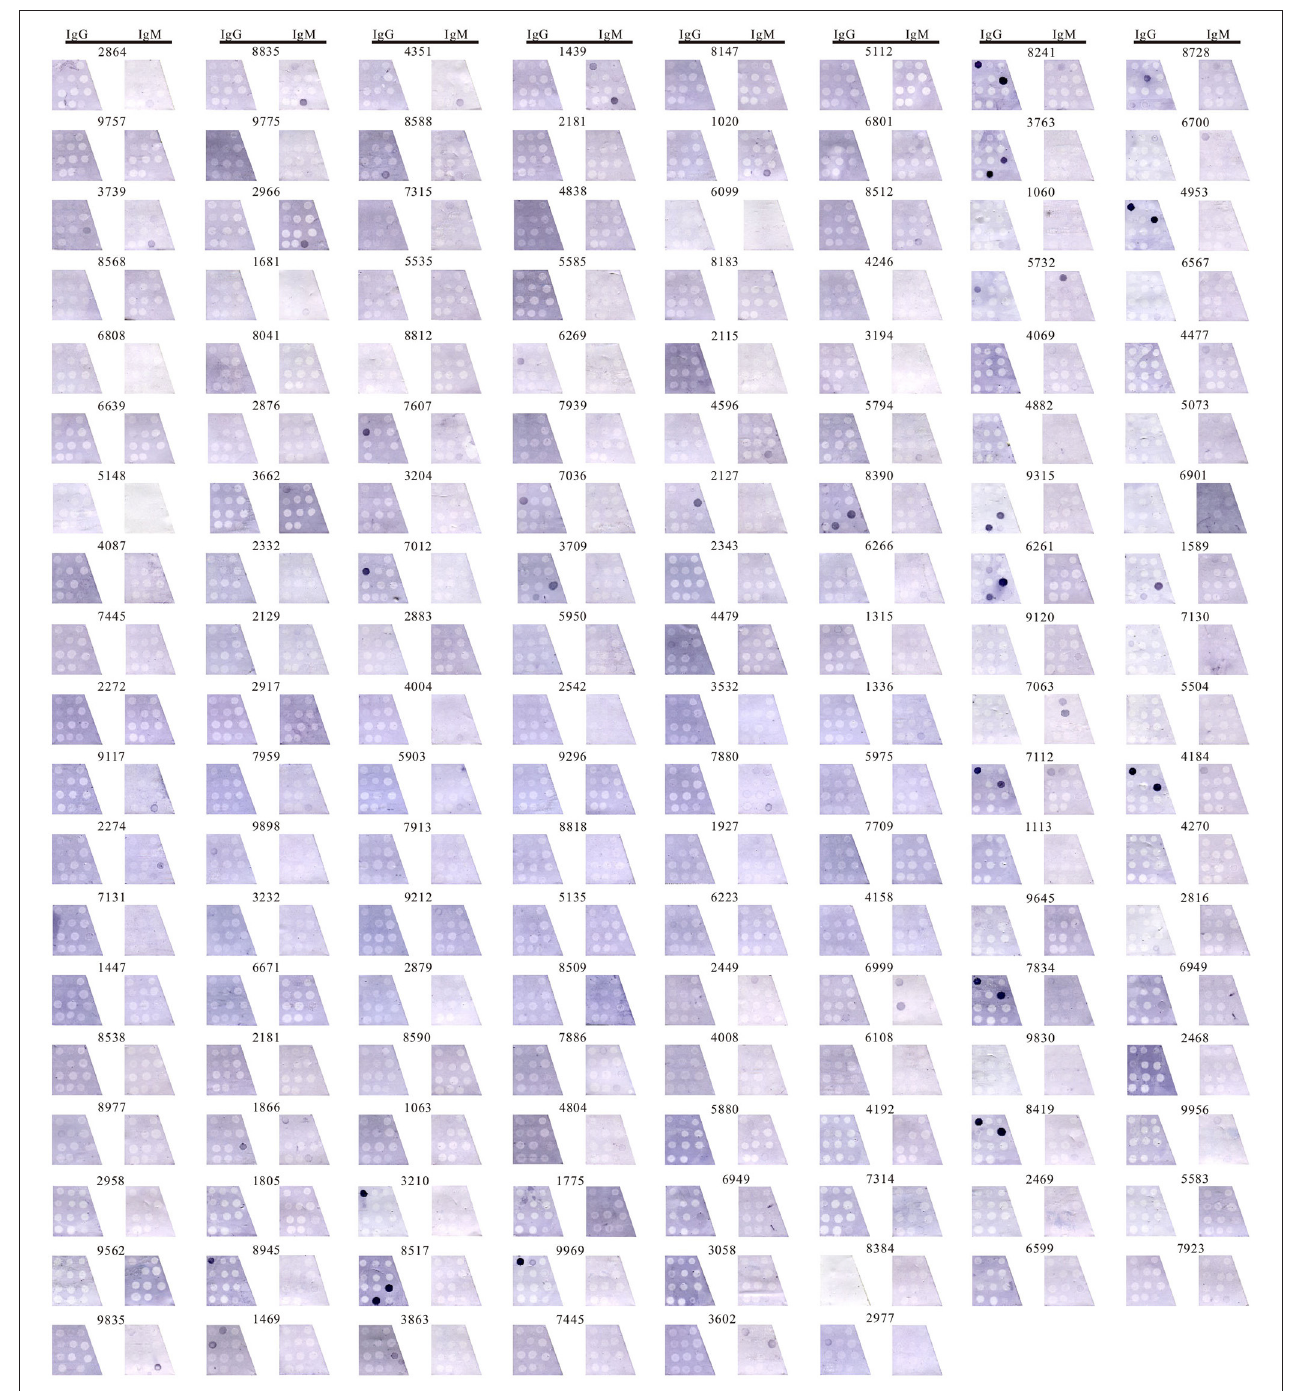
FIGURE 2 | Detecting anti-ganglioside antibodies in 150 participants. Detection IgG-AGAs and IgM-AGAs in 150 samples by immunoblotting assay, including GM1, GM2, GM3, GM4, GD1a, GD1b, GD2, GD3, GQ1b, GT1b, GT1a, and sulfatide.